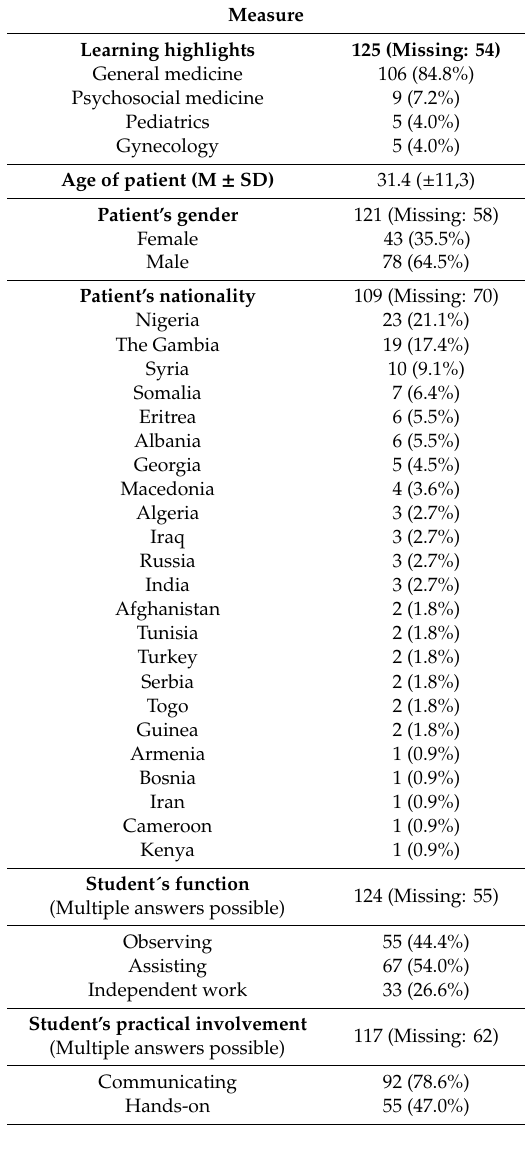
Table 2. Results of the students’ reflective diaries: medical field of learning highlights, age, gender, and nationalities of patients and the students’ individual involvement during the consultation are given in numbers and